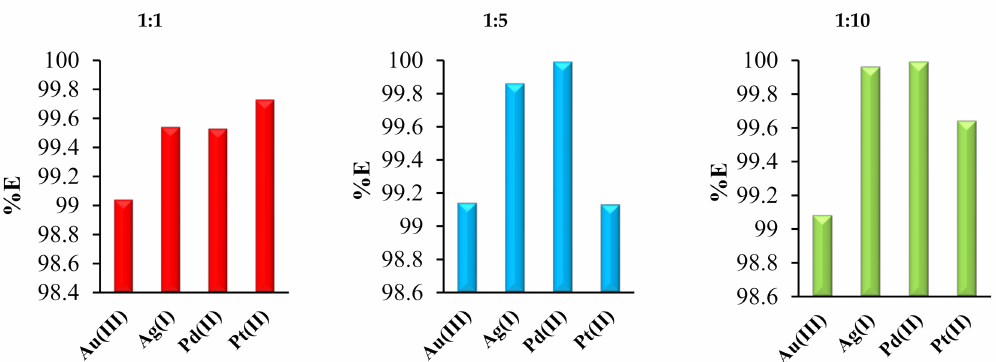
Figure 4. The extraction percentages obtained for various molar ratios of analyzed noble metal ions and 2,6-bis(4- methoxybenzoyl)-diaminopyridine ( L , extractant).